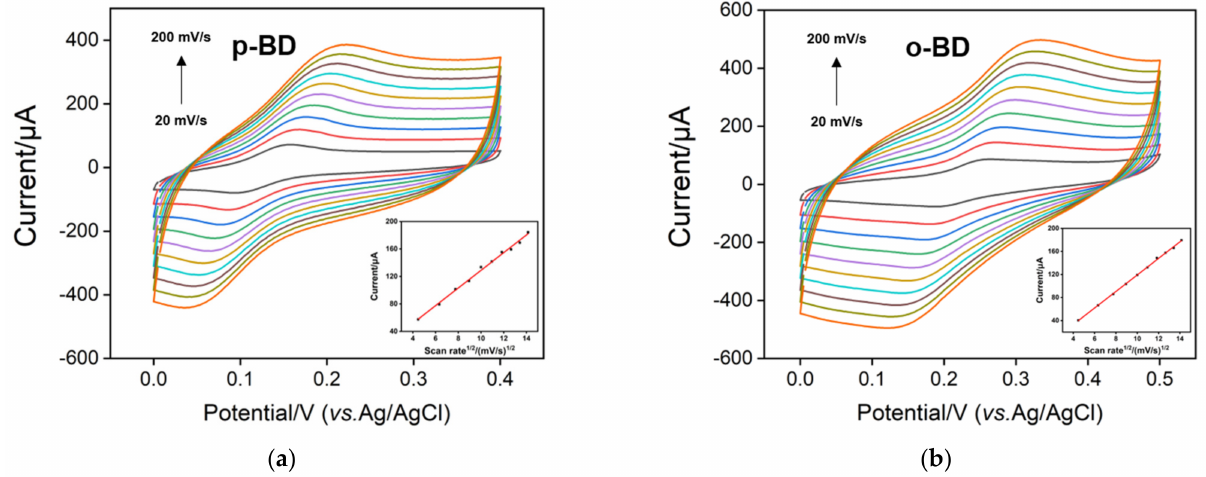
Figure 5. Cyclic voltammetry curves of p-BD ( a ) and o-BD ( b ) on p-3DG at different scan rates. The insets show the dependence of anodic peak currents on the square root of scan rate.